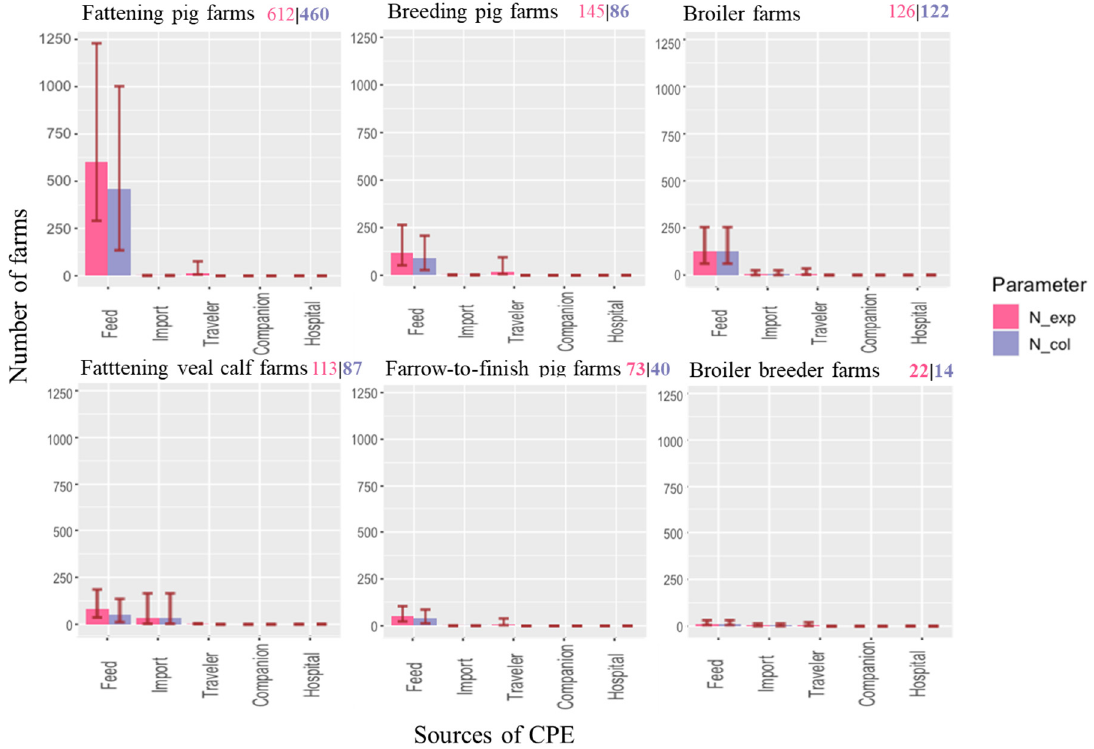
Figure 1. Baseline result: median (whisker: 5th and 95th percentiles) annual number of farms exposed to (red) and colonized by (blue) CPE in each farm type from five sources (feed, imported livestock, returning travelers, companion animals, and hospital patients). The color-coded numbers in the right upper corner of each plot are the total number of farms exposed to CPE and the total number of farms in which CPE has been introduced.